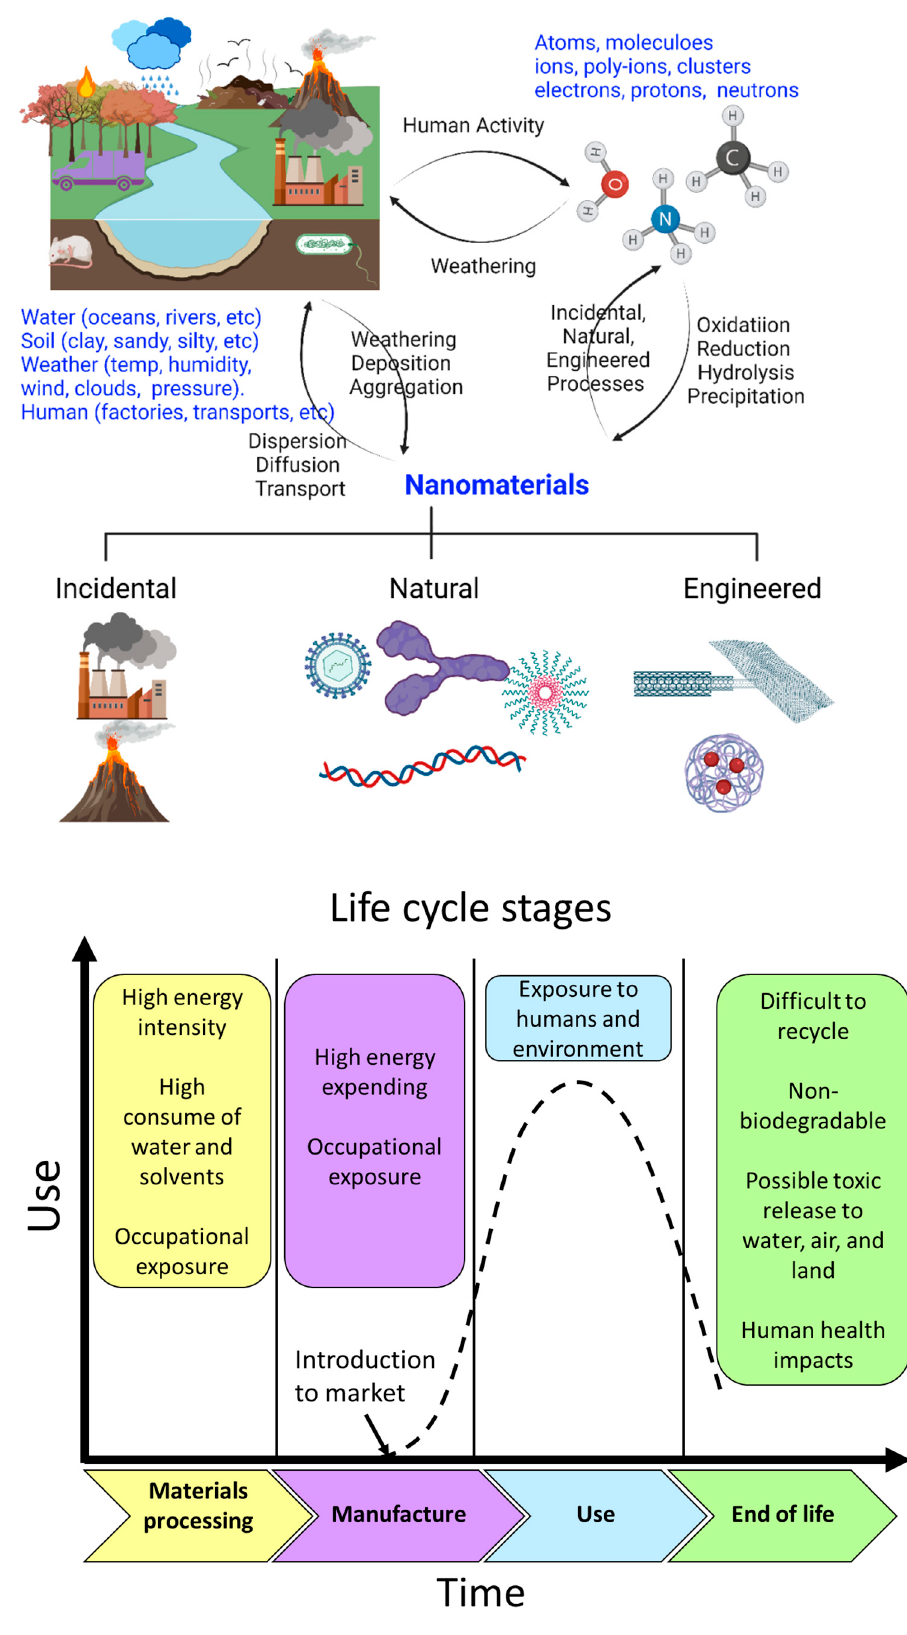
Figure 21. Schematic shows the life cycle of nanomaterials involve their uses over time (Material Extraction, Processing, Manufacturing, Use, and End-of-Life (Recycling/Disposal).